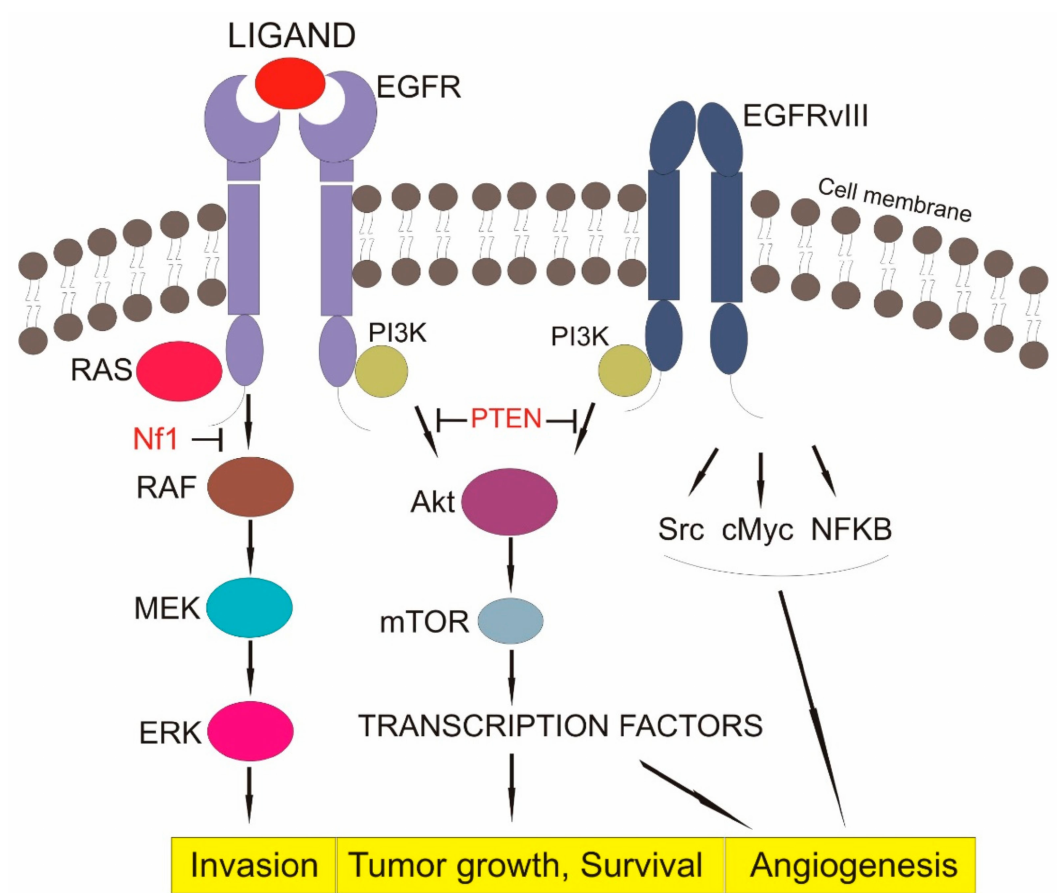
Figure 1. EGFR signaling pathway (EGFR—epithelial growth factor receptor, EGFRvIII—Epidermal growth factor recep- tor variant III, Pi3K—Phosphoinositide 3-kinase, RAS—family of genes involving cellular signal transduction, PTEN— Phosphatase and tensin homolog, NF1—Neurofibromatosis type 1, RAF—serine/threonine-specific protein kinases, MEK— Mitogen-activated protein kinase, ERK—extracellular signal-regulated kinase, AkT—Protein kinase B, mTOR—mammalian target of rapamycin, Src—Proto-oncogene tyrosine-protein kinase, cMyc—c proto-oncogene, NFKB—nuclear factor kappa- light-chain-enhancer of activated B cells, Block arrow—inhibition activity, Point arrow—pathway